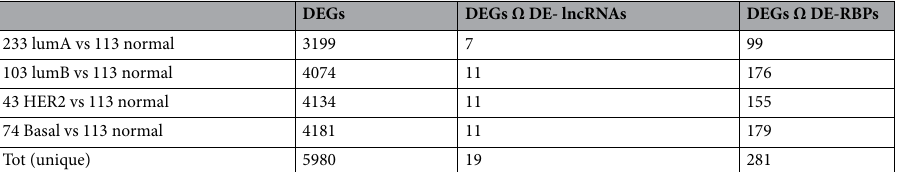
Table 3. The table shows differentially expressed genes (DEGs), differentially expressed long Non-Coding (DE-lncRNAs) RNAs and differentially RNA binding-proteins (DE-RBPs).